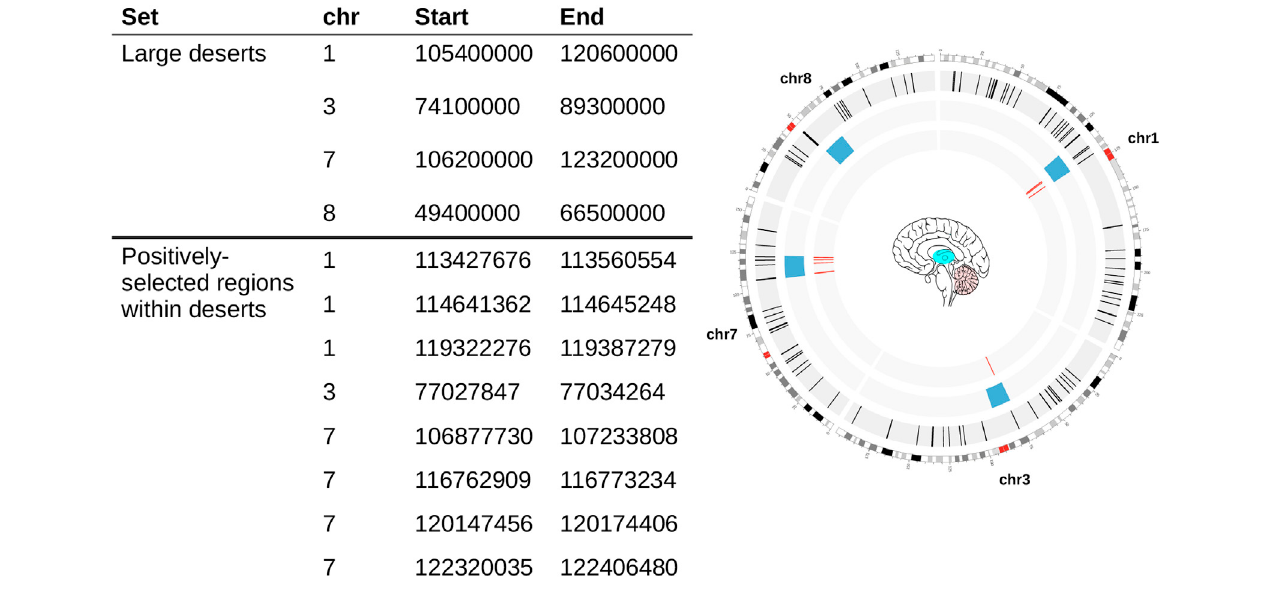
Frontiers in Cell and Developmental Biology |